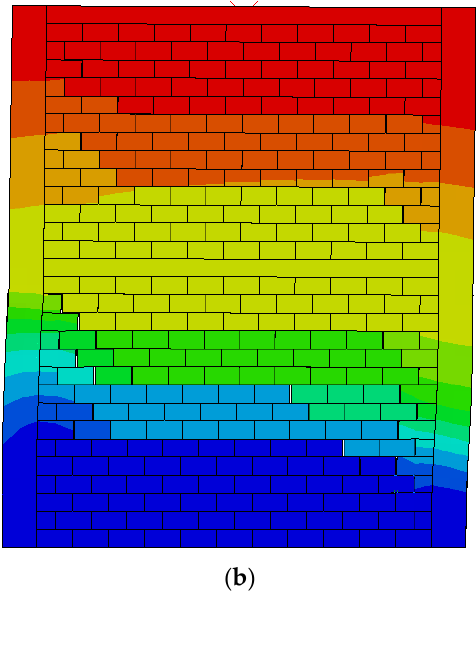
Figure 7. One-half model of MSBD.